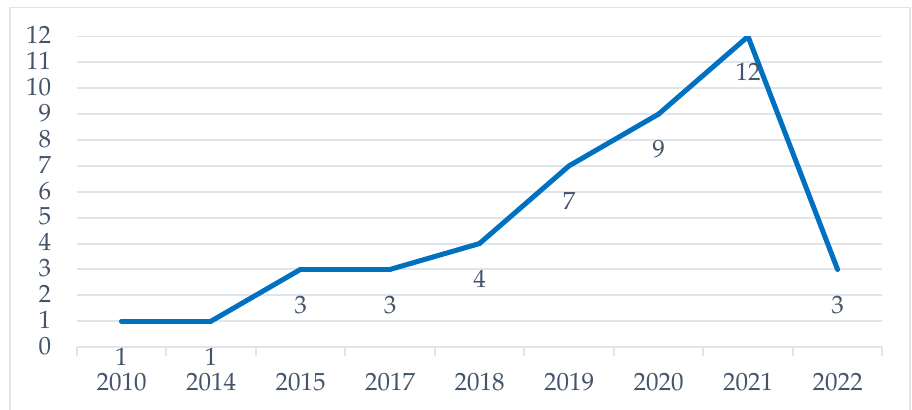
Figure 1. The publication year of design thinking papers.